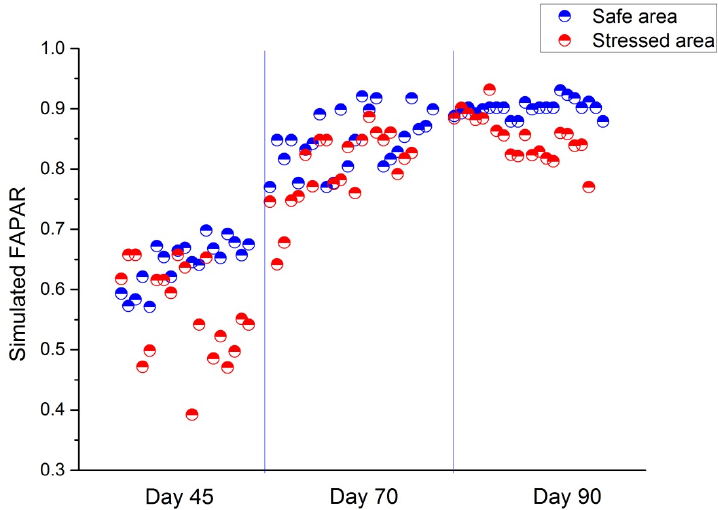
Figure 4. Distribution of simulated FAPAR at different times in different regions. Note that all days mean days after transplanting.